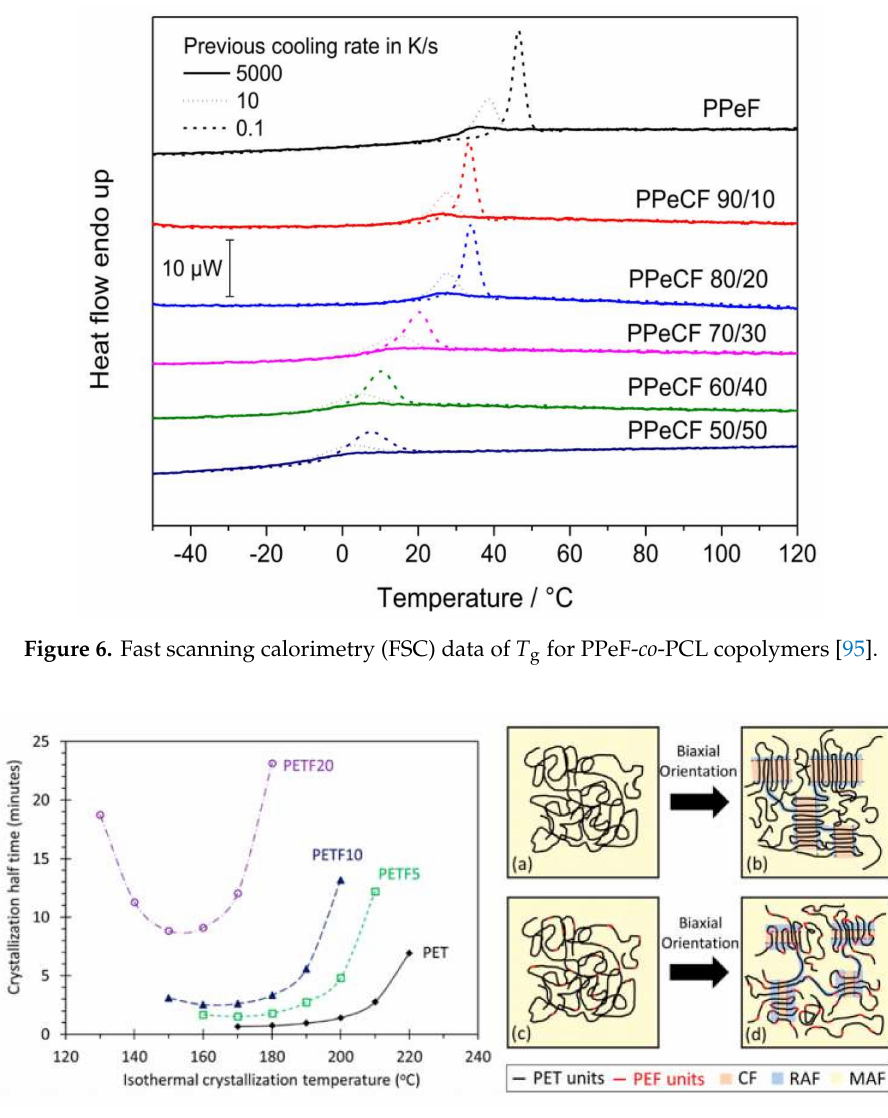
Figure 7. Crystallization and orientation of PEF- co -PET copolymers. Left: Crystallization half-times calculated from the DSC isotherms at di ff erent crystallization temperatures cooling from the melt for PET and PEF- co -PET copolymers with 5, 10 and 20% ethylene furanoate units (PETF5, PETF10 and PETF20 respectively). Right: Simplified schematic showing amorphous and crystalline fractions in chain folds and inter lamellar regions of ( a ) unoriented PET, ( b ) biaxially oriented PET, ( c ) unoriented PEF- co -PET random copolyester, and ( d ) biaxially oriented PEF- co -PET random copolyester; CF:crystalline fraction, RAF: rigid amorphous fraction, MAF: mobile amorphous fraction